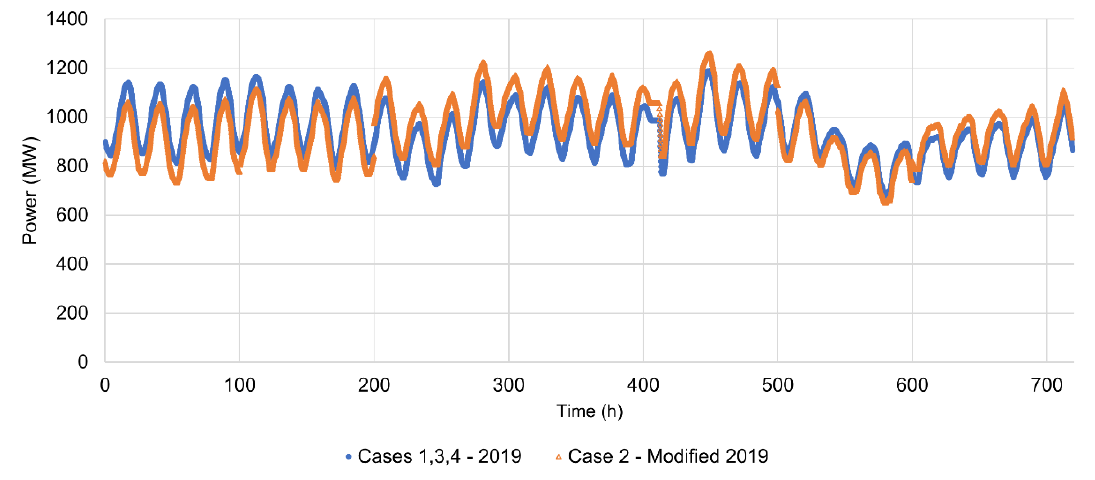
Figure 7. 2019 total and modified electricity demand load.